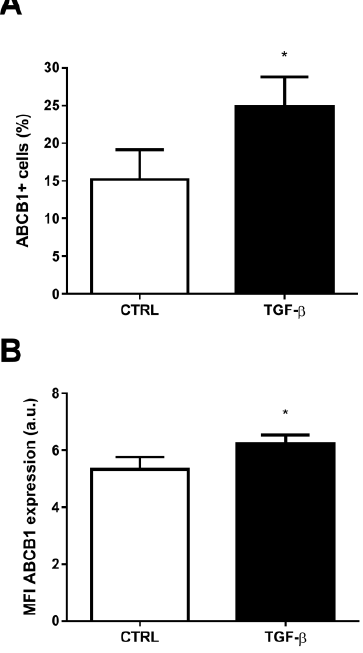
Figure 3. TGF- β increases ABCB1 expression. A549 cells (1 × 10 5 cells/mL) were incubated with 5 ng/mL TGF- β for EMT induction. After 48 h, the cells were stained with anti-ABCB1 antibody and ( A ) percentage of positive cells and ( B ) protein expression were evaluated by flow cytometry. Expression is represented by median fluorescence intensities (MFI). Bars represent mean + SEM, and the values of significance were represented by (*) for p < 0.05 from six independent experiments.